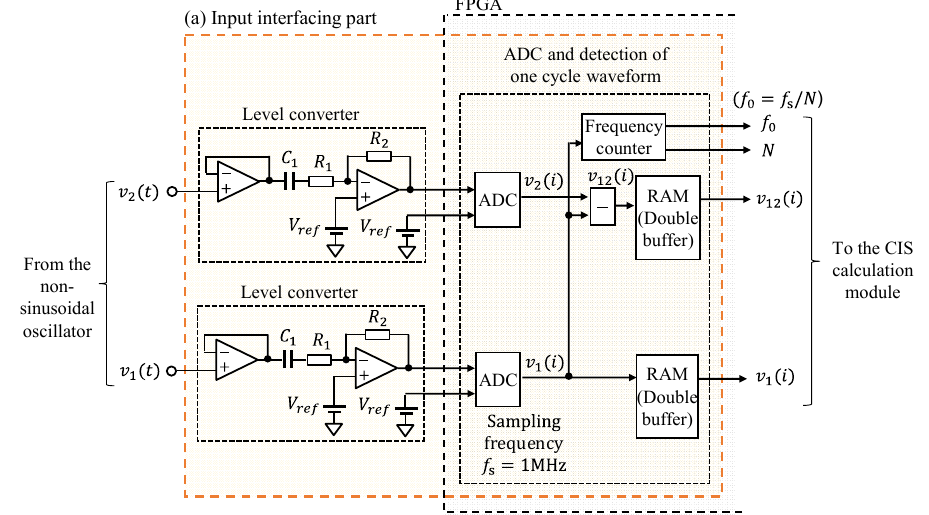
Figure 2. Detailed illustration of the input interfacing part written in Figure 1. In the ADC and single-cycle waveform module detection, the ADC used the Xilinx ADC (XADC) built into the FPGA. The XADC is a successive approximation register type with a 12-bit resolution, 1 mega sample per second (sampling frequency f s = 1 MHz), input voltage range of 0–1 V, and differential input, and AD conversion is possible for two channels simultaneously. v 1 ( t ) and v 2 ( t ) after AD conversion were expressed as v 1 ( i ) and v 2 ( i ) . The rising edge of the waveform from negative to positive was detected by monitoring v 1 ( i ) . Moreover, this block had a frequency counter at the detected